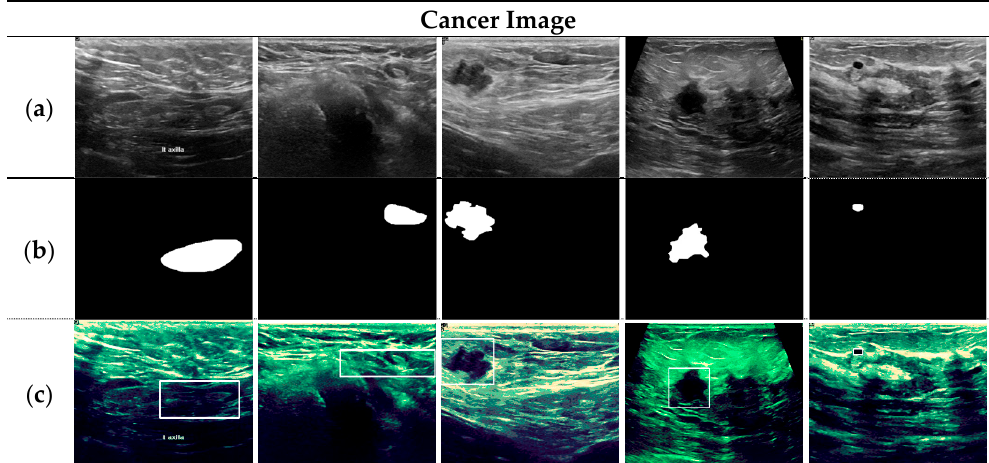
Figure 13. The results detected in the proposed method and mask set: ( a ) original image; ( b ) mask set provided by AI-Dhabyani, W.; ( c ) image extracted through preprocessing.